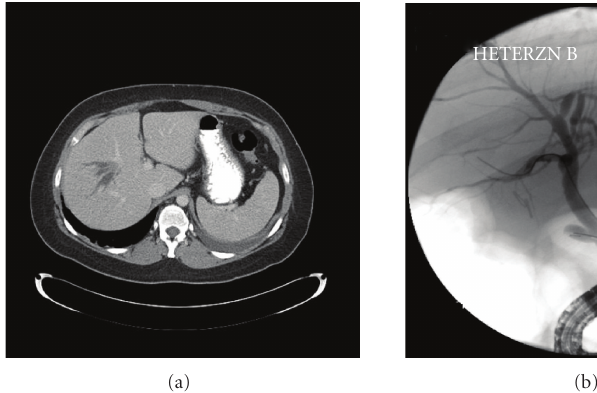
intrahepatic ducts in a segment of right hepatic